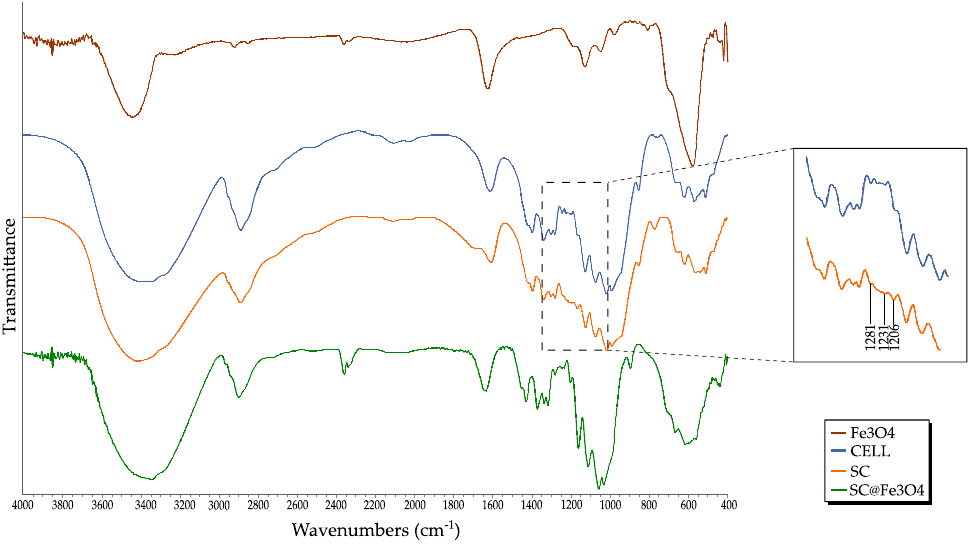
Figure 1. Fourier transform infrared (FTIR) spectra comparison between Fe 3 O 4 IONs, cellulose (CELL), sulfonated cellulose (SC), and magnetic composite (SC@Fe 3 O 4 ).